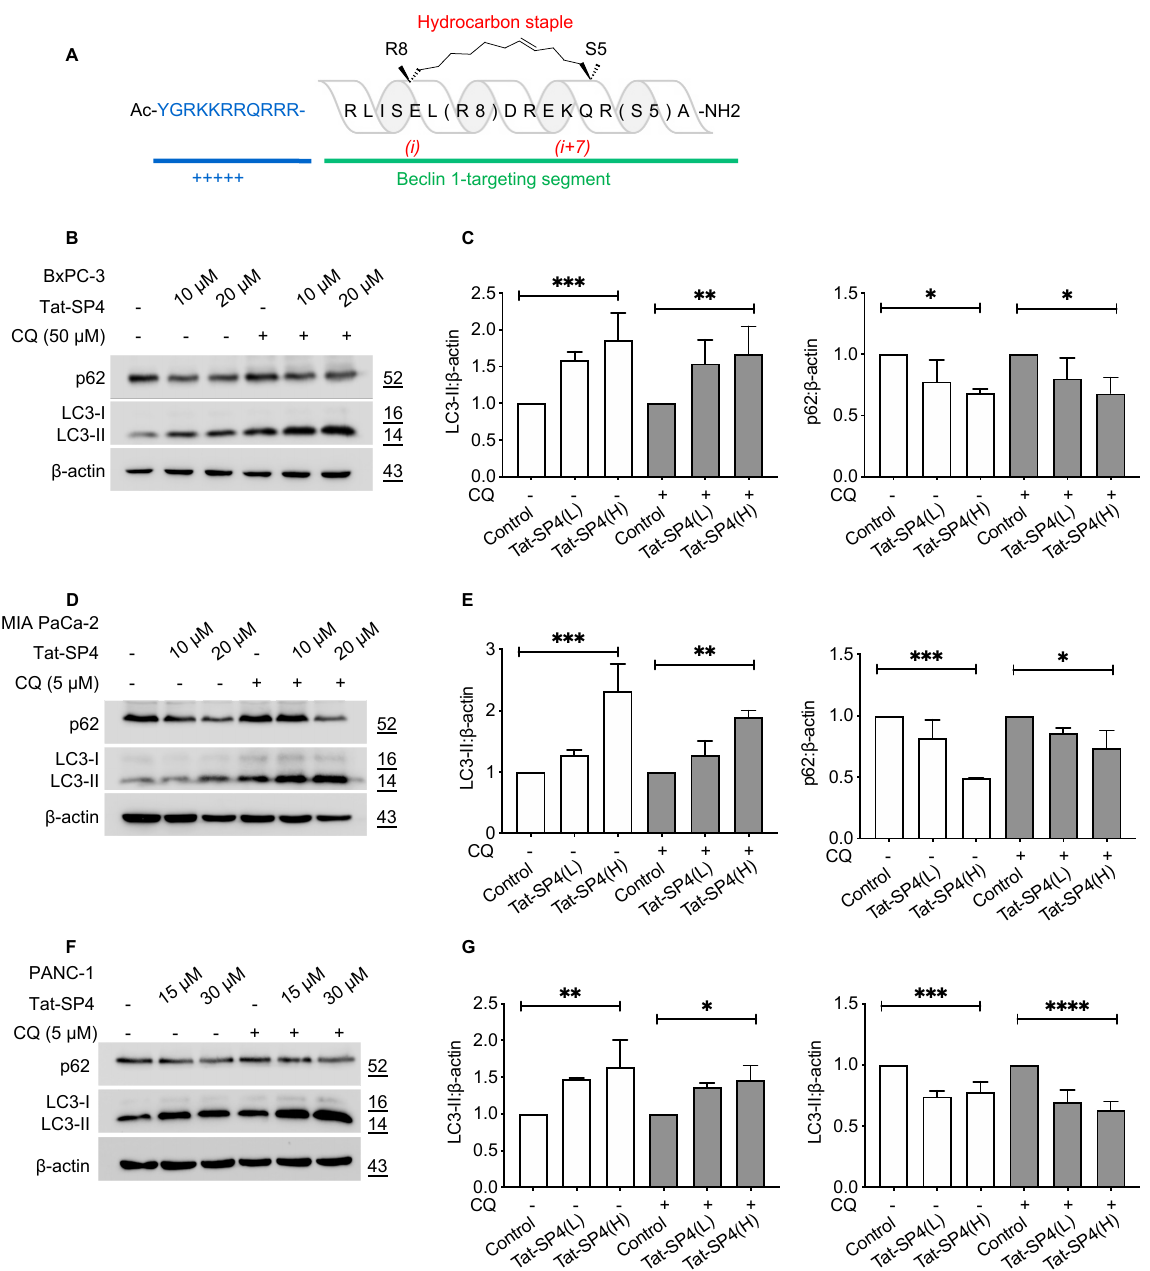
Figure 1. Tat-SP4 induced autophagy in multiple PDAC cell lines. ( A ) Sequence and chemical structure of Tat-SP4. A cell-penetrating Tat sequence (colored in blue) is added to the N terminal